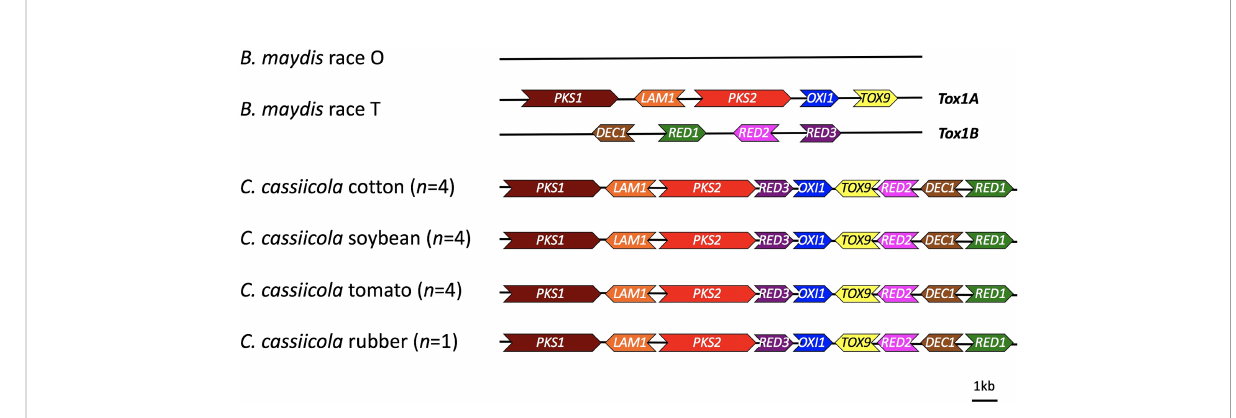
FIGURE 3 Schematic diagram of the structure of T-toxin biosynthetic genes identi fi ed in Corynespora cassiicola isolates sampled and sequenced for this study. The genes pks1 (AAB08104.3), lam1 (ACP43390.1), pks2 (ABB76806.1), oxi1 (ADB23430.1), tox9 (ADB23431.1), dec1 (AAM88291.1), red1